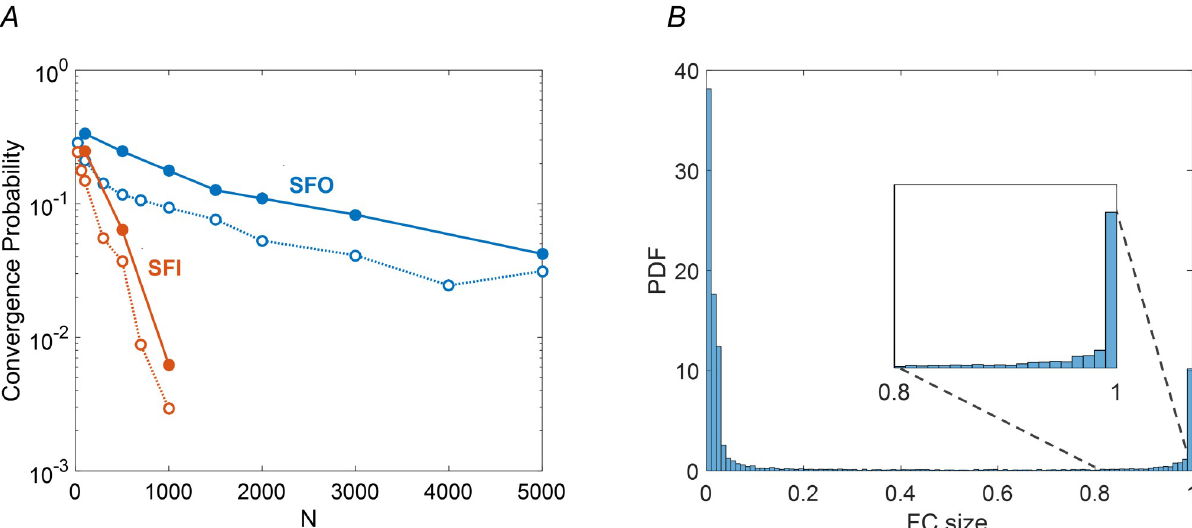
Fig 1. Dynamic properties of Scale-Free-Out (SFO, blue) vs. Scale-Free-In (SFI, red) network ensembles. (A) Convergence probability is shown as a function of network size N . Filled circles show convergence to frozen cores larger than 90% of the network; open circles show convergence to fixed points. Each data point represents an ensemble average over 600 networks with random T , J and initial conditions. (B) Distribution of frozen core sizes (FC) relative to network size, across the SFO ensemble for N = 1500. The distribution is further zoomed near FC = 1 justifying the notion of quasi fixed point, defined in the text and elaborated in Materials and methods. Scale free parameters for both panels are γ = 2.2 and k are N and p = k / N with k * 5 (exact value of k is determined by the realization of scale free distribution. See Materials and methods for details).